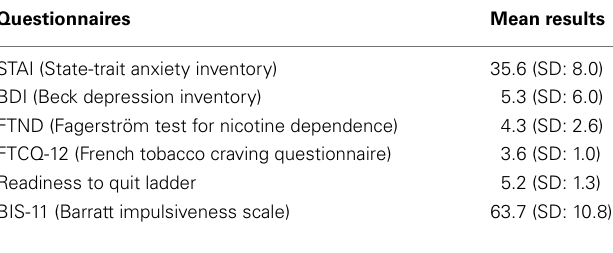
Table 1 | Demographic data. Standard deviation (SD) in